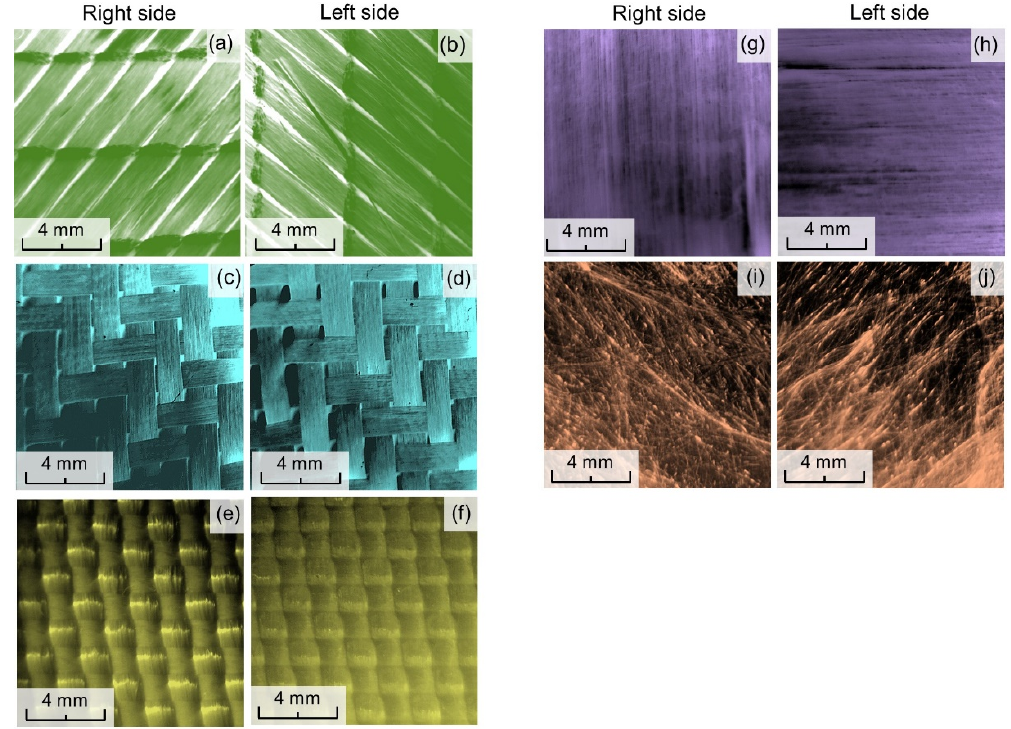
Figure 1. Optical microscopy images of both sides of tested textiles: CBXS400 ( a , b ), GG200T ( c , d ), Twaron CT736 ( e , f ), Dyneema HB26 ( g , h ), T1790C ( i , j